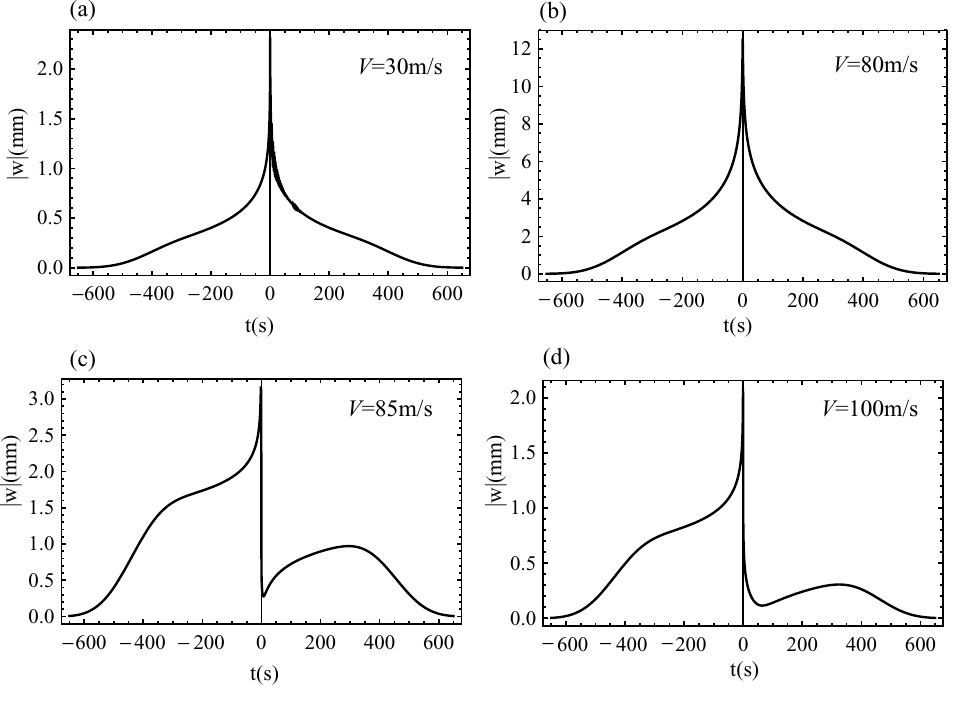
(cid:3) ( Re [ w ]) 2 + ( Im [ w ]) 2 of the vertical displacement for distributed harmonic load ( r = 10 m, Ω ≈ 0 ) Fig. 10. The complex modulus | w | = and the velocity: (a) V = 30 m/s, (b) V = 80 m/s, (c) V = 85 m/s, (d) V = 100